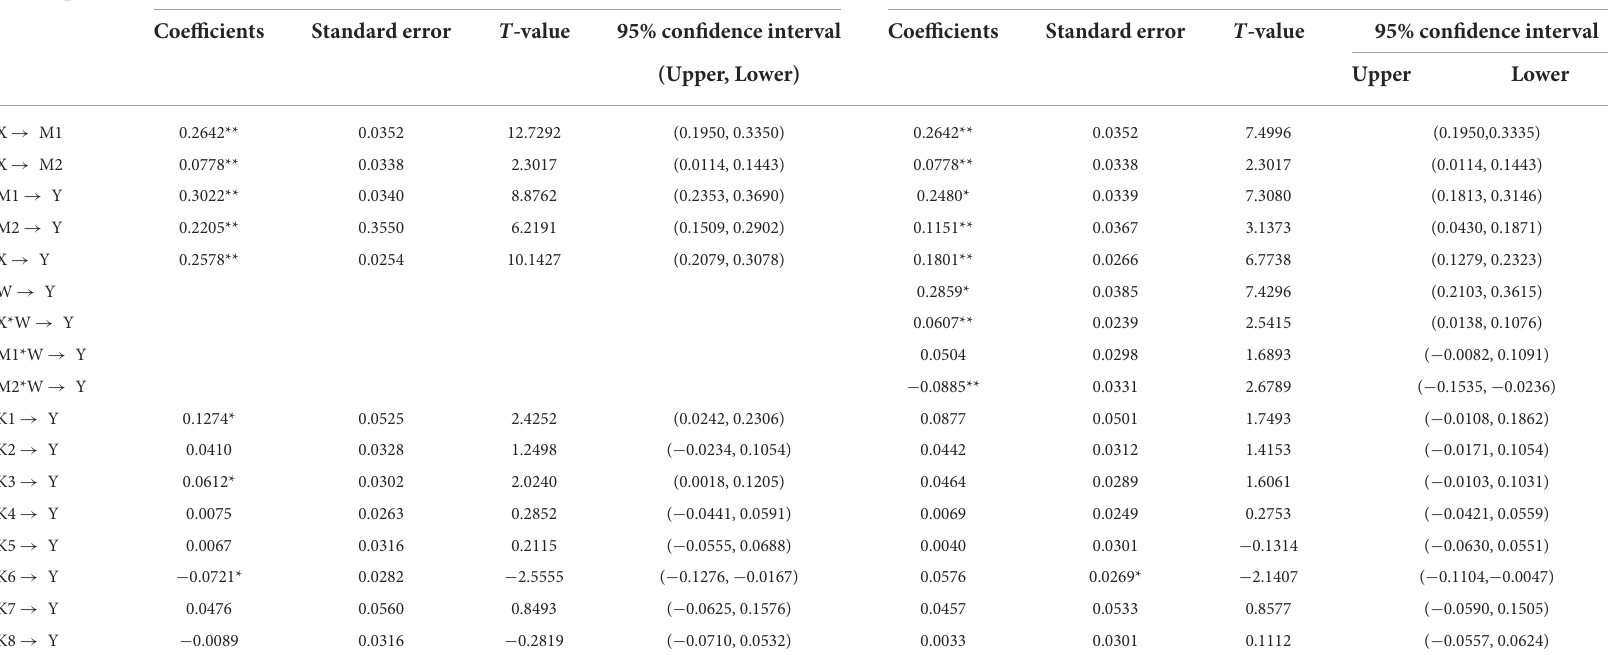
TABLE 5 Hierarchical regression analysis of moderation effect ( N =